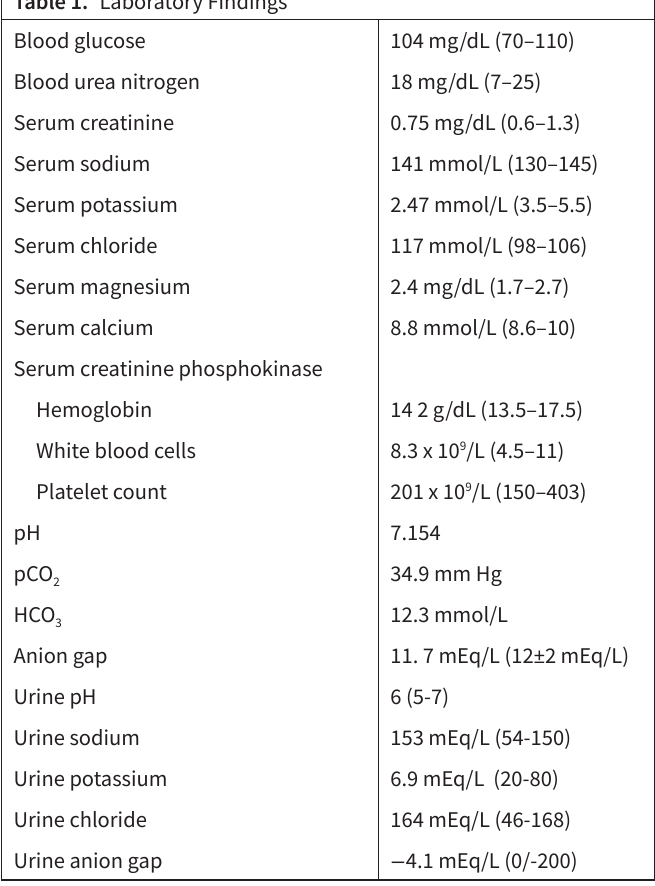
Table 1. Laboratory